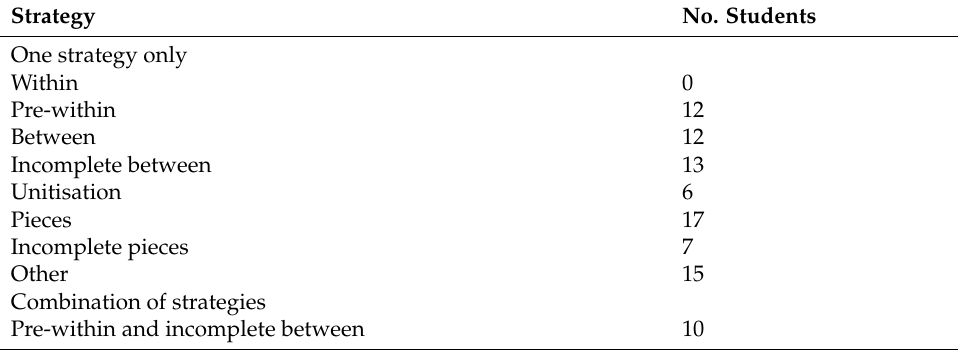
Table 5. Frequency of use of each